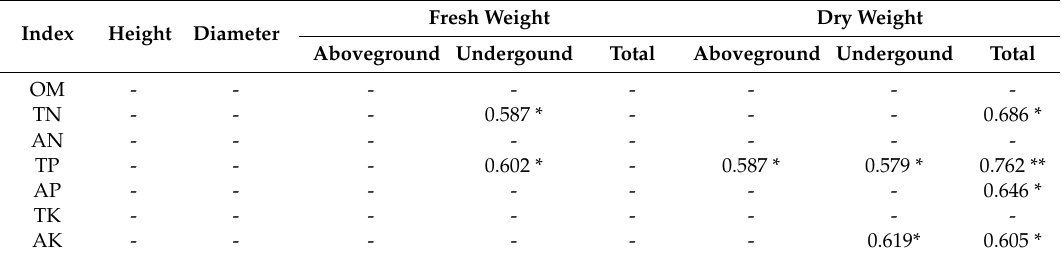
Table 4. The correlations of seedling biomass with soil physicochemical